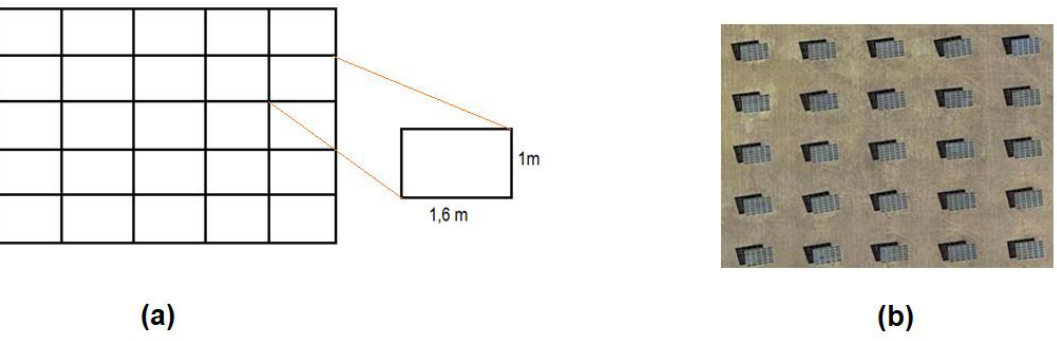
Figure 7. Design characteristics of the “El Molino” facility: ( a ) Constitution of the collectors; ( b ) Arrangement of collectors.